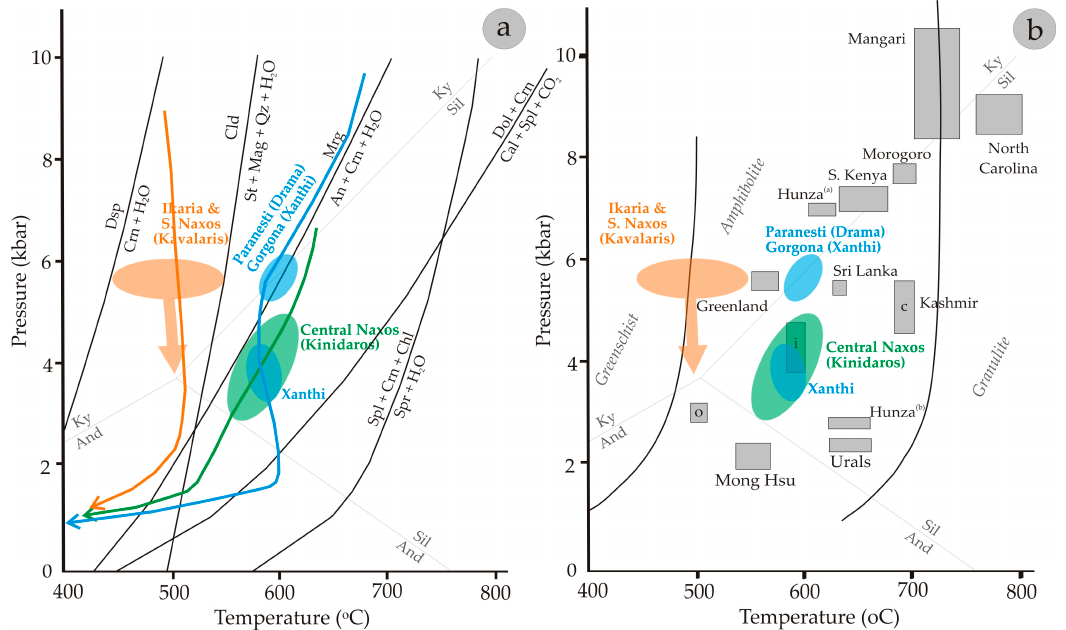
Figure 13. ( a ) P–T diagram showing mineral equilibria related to the formation of corundum in Greece (modified from Garnier et al. [117]). Upper blue area: Paranesti ruby and Gorgona sapphires ([30] and this study); Lower blue area: Alternative conditions for the Gorgona sapphires (for explanation see text); Orange area: Ikaria and southern Naxos metabauxites. The thick orange arrow indicates possible path for formation of vein-type sapphires from both localities; Green area: Central Naxos plumasites. Blue arrow: P–T–t path of high-grade rocks from the Nestos suture zone (from Krenn et al. [57]); Green arrow: P–T–t path of the tourmaline-garnet-beryl-bearing leucogranite from Naxos island (from Siebenaller [119]); Orange arrow: P–T–t path of the lower limit of metamorphic zone III (which hosts corundum-chloritoid-bearing metabauxites) from Naxos island (from Duchêne et al. [64]). The equilibrium curve “chloritoid + O 2 = staurolite + magnetite + quartz”, which marks the disappearance of chloritoid, defines an upper limit for the studied chloritoid-bearing metabauxites at southern Naxos (Kavalaris) and Ikaria islands is from Feenstra [21]. Abbreviations: An = anorthite; And = andalusite; Cc = calcite; Cld = chloritoid; Clin = clinochlore; Co = corundum; Do = dolomite; Dsp = diaspore; Ky = kyanite; Ma = margarite; Mag = magnetite; Qz = quartz; Sill = sillimanite; Spr = sapphirine; Sp = spinel; St = staurolite; ( b ) Comparison between the hypothetical P–T conditions for the formation of corundum in Greece and in metamorphic deposits around the world (modified from Giuliani et al. [7], Simonet et al. [3]). Boxes indicate P–T fields of known deposits: North Carolina, Rubies from